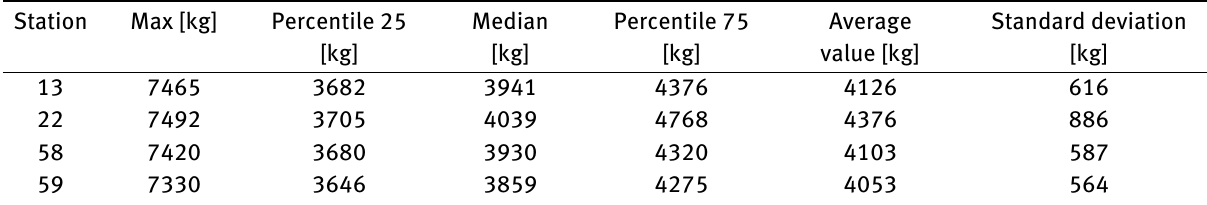
Table 6: Descriptive statistics for the weight of overloaded category 11 vehicles